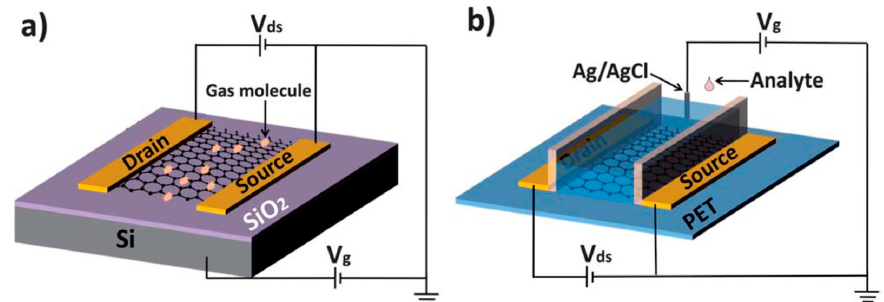
Figure 65. ( a ) Typical back-gate graphene-based field-effect transistor (GFET) on Si/SiO 2 substrate used as gas sensor, and ( b ) typical solution-gate GFET on flexible polyethylene terephthalate (PET) substrate used as chemical and biological sensor in aqueous solution [412].